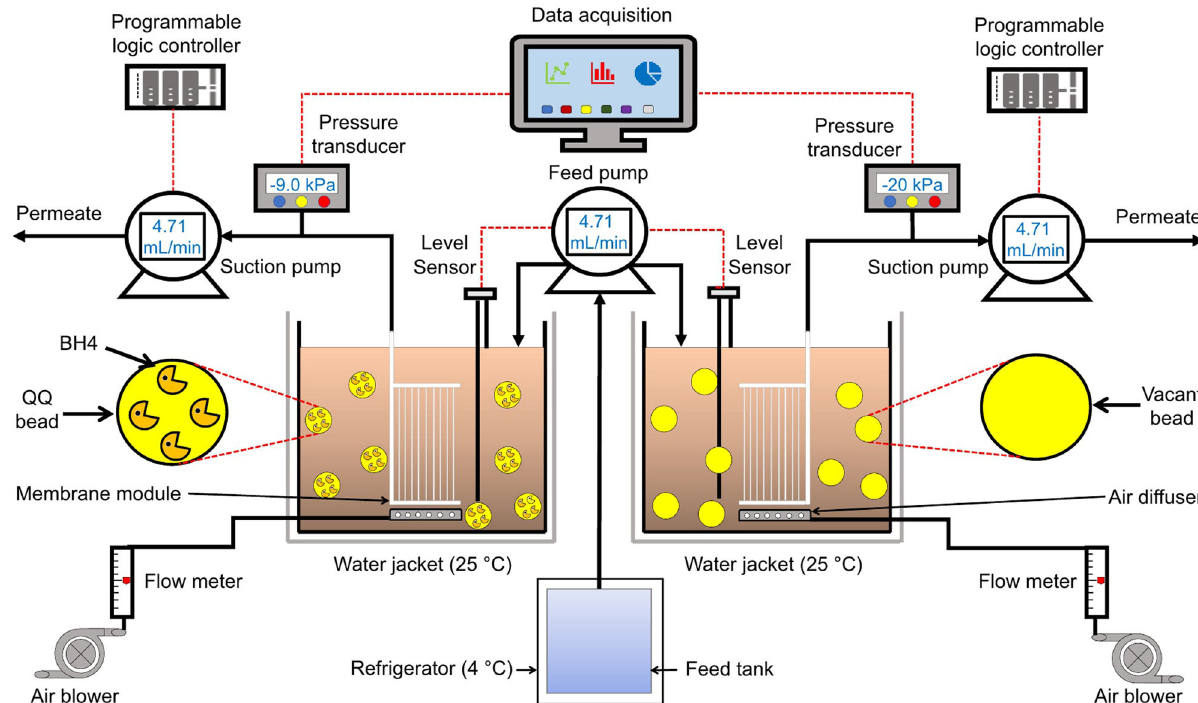
Fig. 5 Reactor con fi gurations. Schematic of the laboratory-scale MBRs operated under different conditions, which are detailed in Table 2.